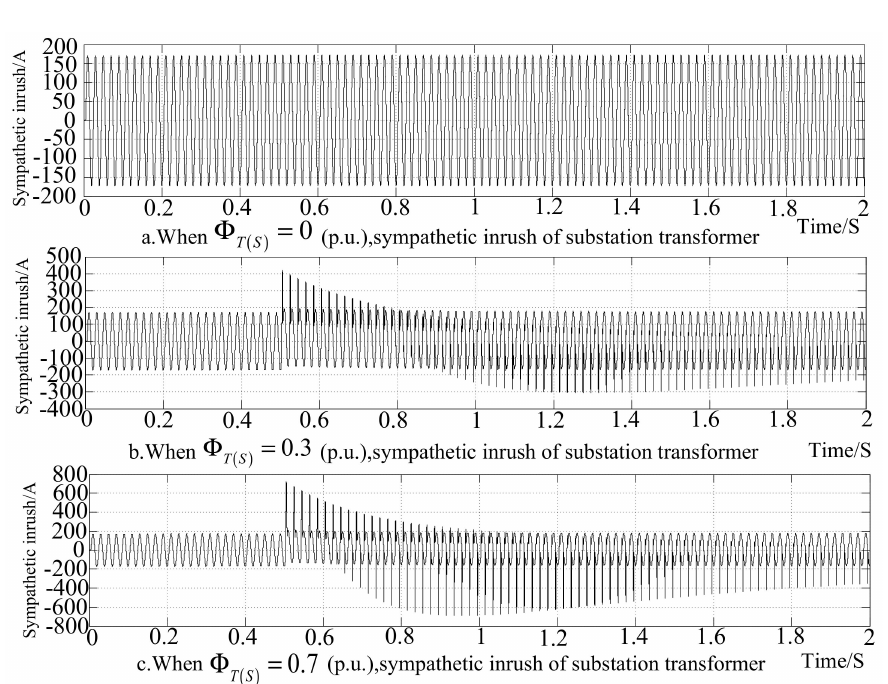
Figure 11. Sympathetic inrush under di ff erent transient flux